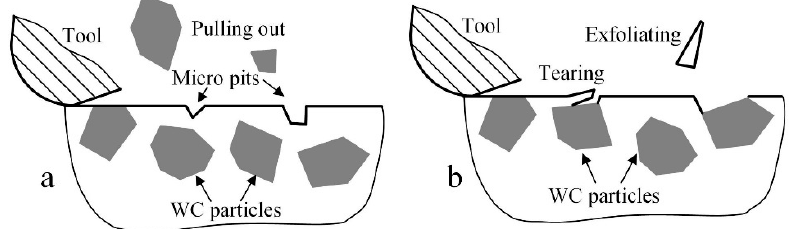
Figure 8. The surface damages mechanism during micromilling of the multiphase material. ( a ) Pulling out; ( b ) tearing and exfoliating.